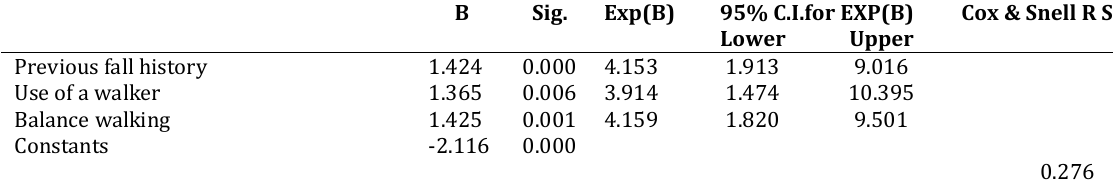
Table 3. Binomial Logistic Regression Test Analysis